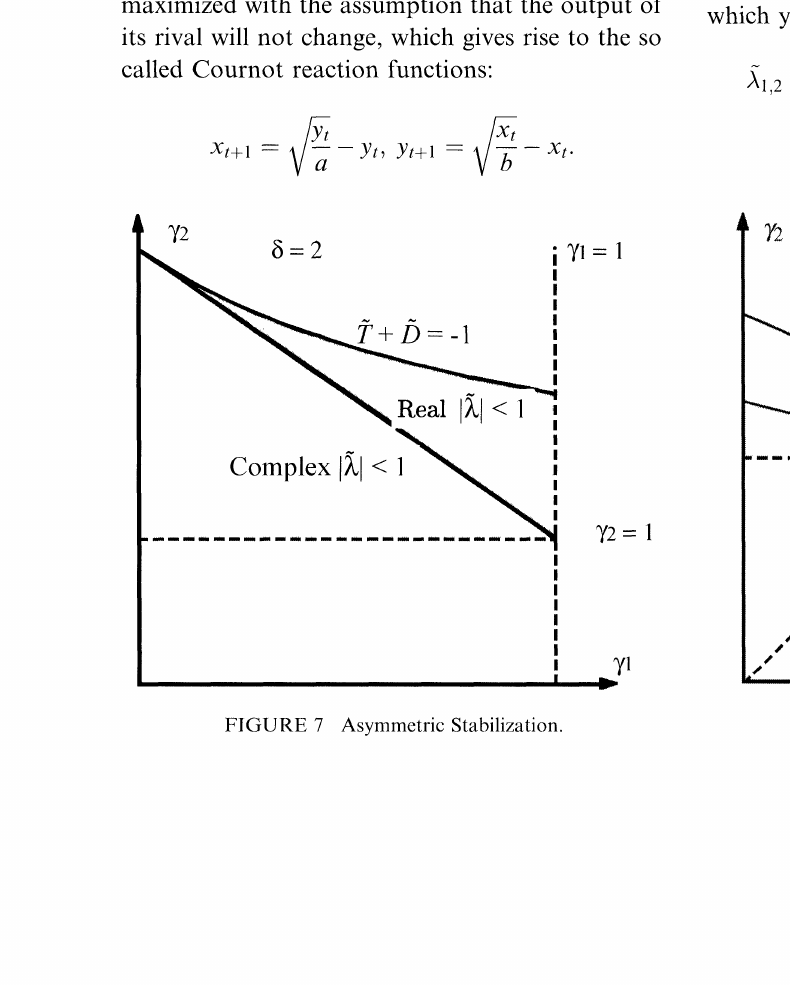
FIGURE 7 Asymmetric Stabilization. FIGURE 8 Symmetrical